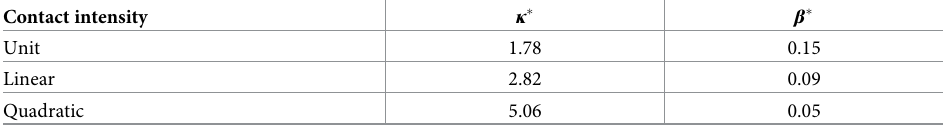
Table 1. Population averages for κ � and β � using different levels of contact